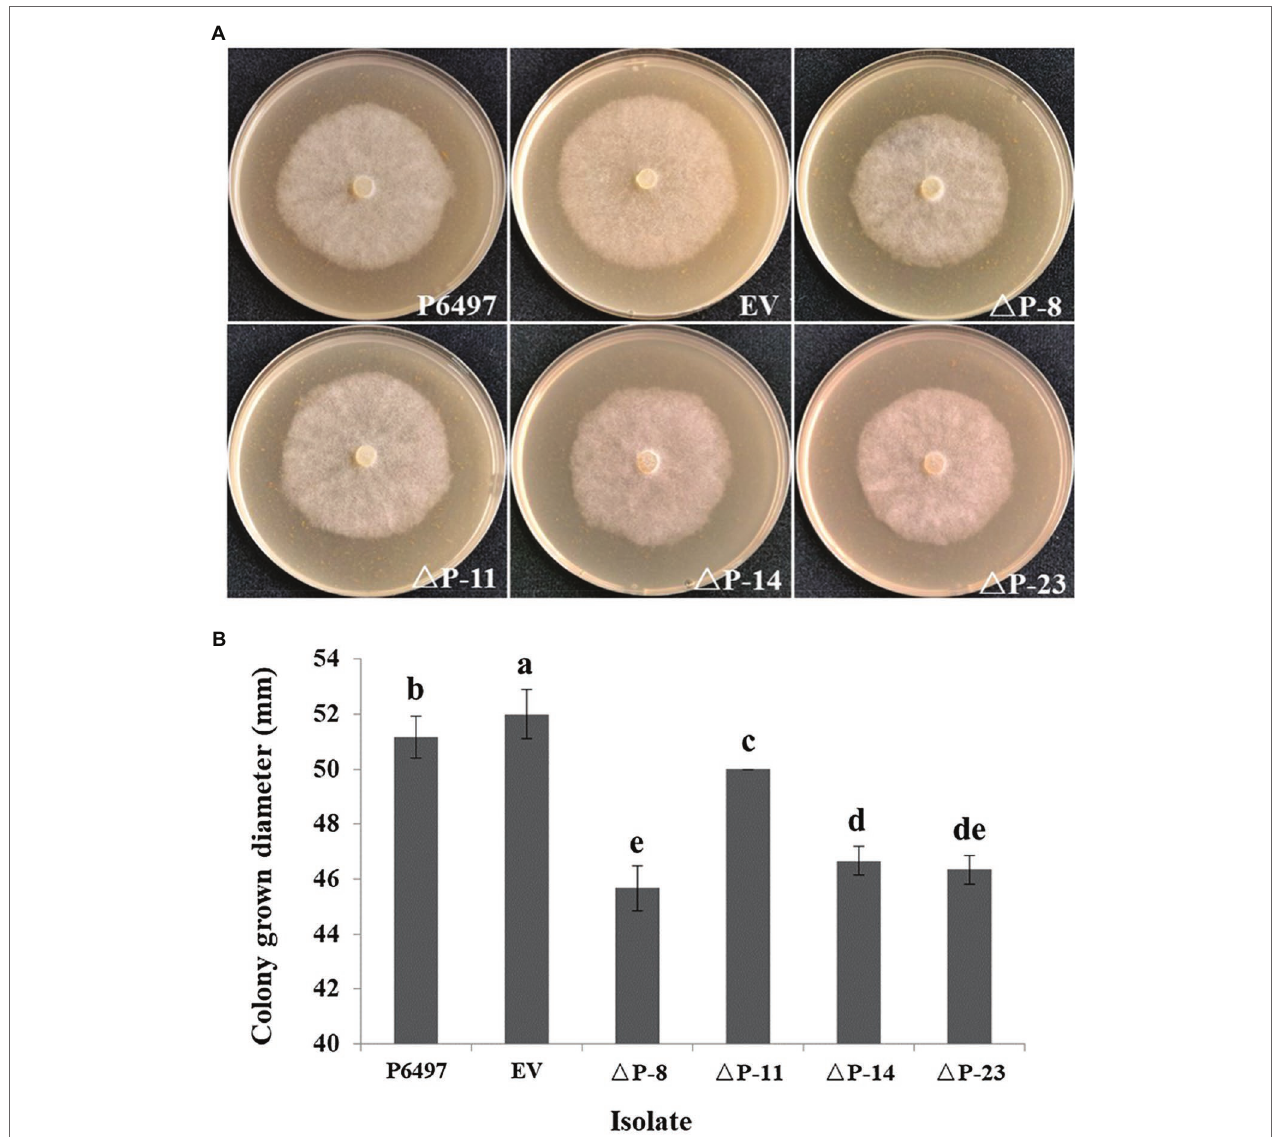
FIGURE 5 | Mycelial growths of PsPTL mutants. (A) Growth characteristics after 4 days on 10% V8 agar medium of the wild-type (P6497), control strain (EV), and PsPTL mutants ( Δ P-8, 11, 14, 23). (B) Mycelial growth diameters after 4 days on 10% V8 agar medium. Columns indicate means, and bars signify SDs. Different letters above the columns indicate statistically significant differences ( p <